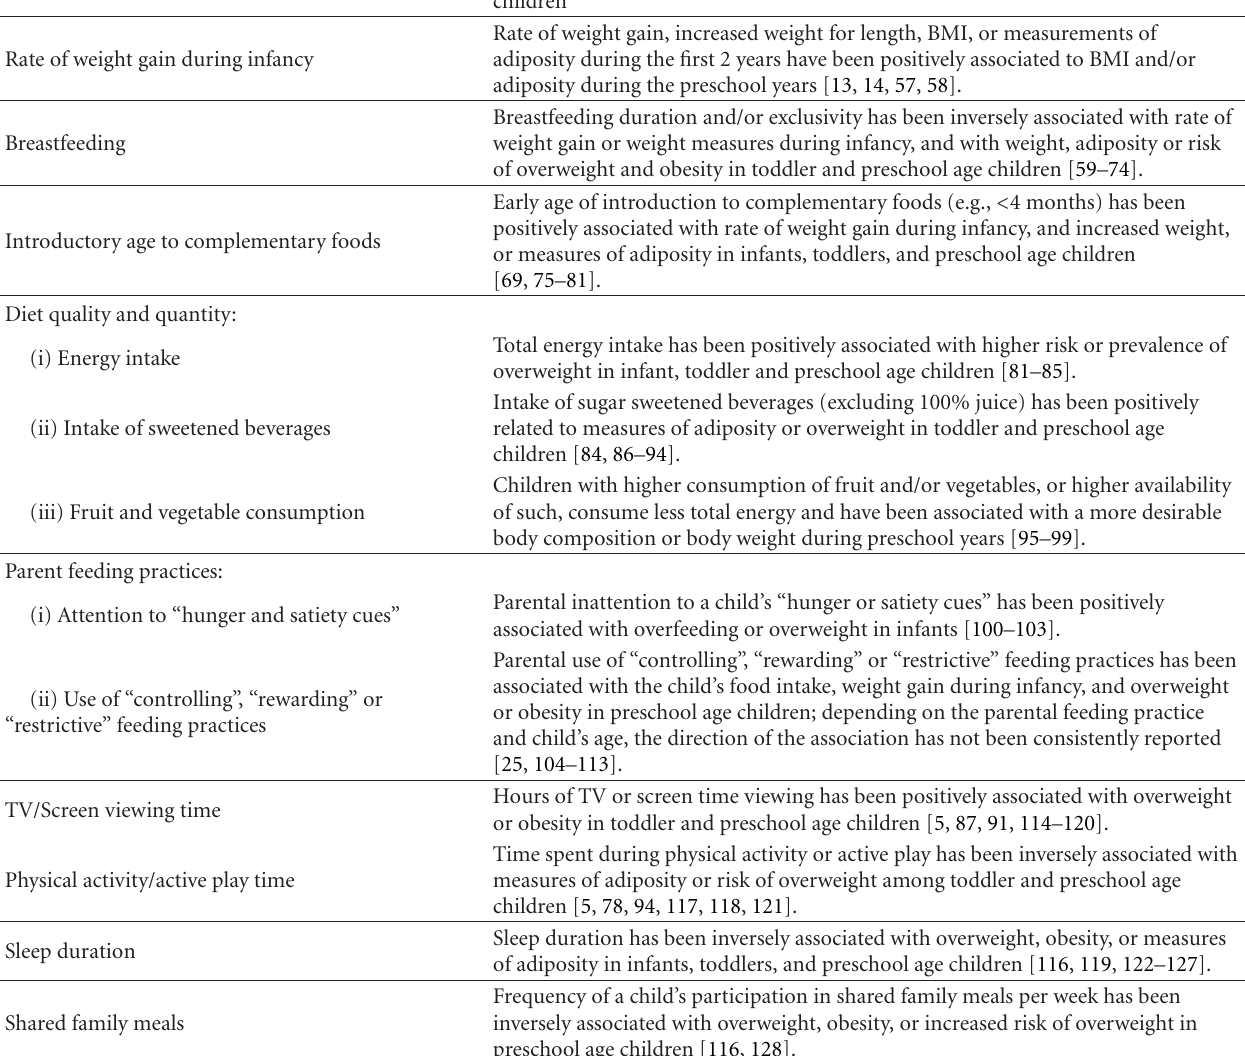
Table 1: Modifiable feeding and related practices associated with overweight or obesity in infants through preschool age children. Direction of association to overweight or obesity in infants through preschool age Feeding and related practices children Rate of weight gain during infancy